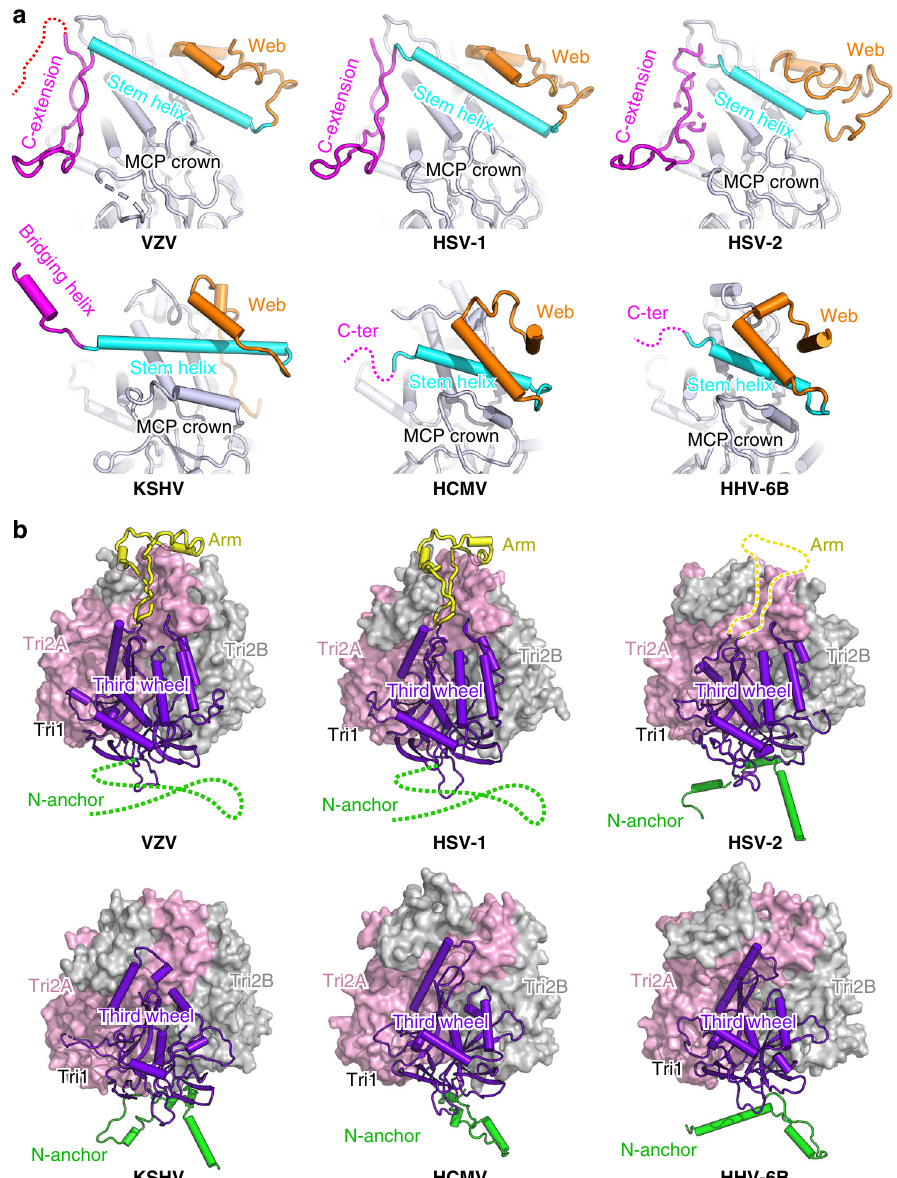
Fig. 6 Group-speci fi c structural features in herpesvirus capsid proteins. a Comparison of SCP in different herpesviruses and its binding to the MCP. The MCP is colored in gray and the SCP is colored by domains. The disordered regions are represented by dashed lines. b Structures of the heterotriplex in different herpesviruses. The two Tri2 subunits are shown as surface models (colored by chains) and the Tri1 molecule is shown as a cartoon model (colored by domains). The Tri1 N-anchor in VZV and HSV-1 and the insertion arm in HSV-2, which are represented by dashed lines, were not resolved in the